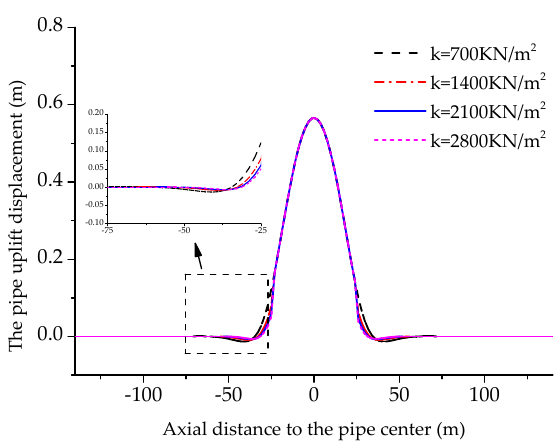
Figure 17. Vertical deformations for pipes buried in soils with various soil spring stiffness.